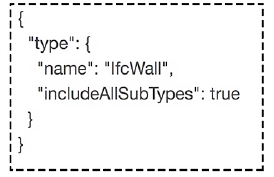
Figure 9. Java Query Engine Language script to query a